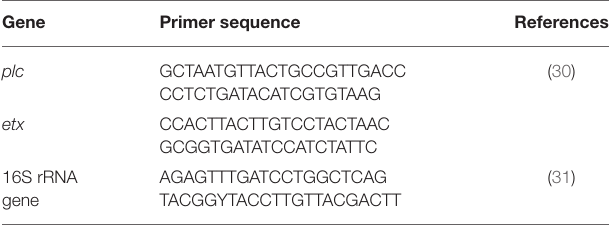
TABLE 1 | Primers used for sequencing of